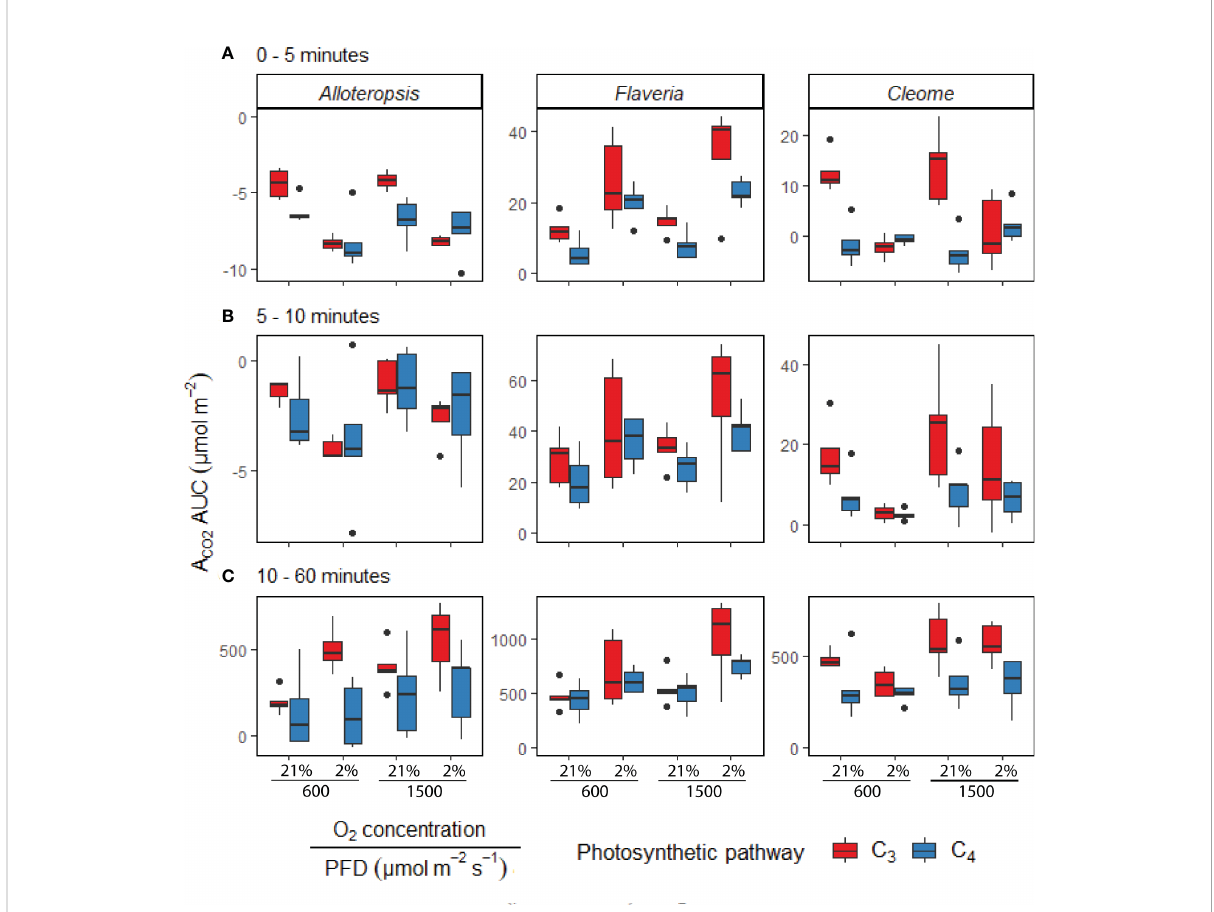
FIGURE 5 Boxplots of cumulative CO 2 assimilation over different phases of light induction in phylogenetically linked C 3 and C 4 Alloteropsis , Flaveria and Cleome species, under different light and O 2 treatments (n = 5 for each combination of species/measurement condition). Box edges represent fi rst and third quartiles, the solid line indicates the median, and points represent outliers beyond 1.5 times the interquartile range. The area under the curve (AUC) was calculated from the A CO2 of light induction experiments where plants at 21% or 2% O 2 concentrations were dark-adapted and exposed to PFD = 600 µmol m -2 s -1 or PFD = 1500 µmol m -2 s -1 for 1 hour. Plots show the AUC of induction during 0 – 5 minutes (A) , 5 – 10 minutes (B) , and 10 – 60 minutes (C) . Two-way ANOVAs (Table 3) were used to test the effect of photosynthetic pathway, O 2 concentration and their interaction on A CO2 AUC at different phases of light induction in Alloteropsis, Flaveria , and